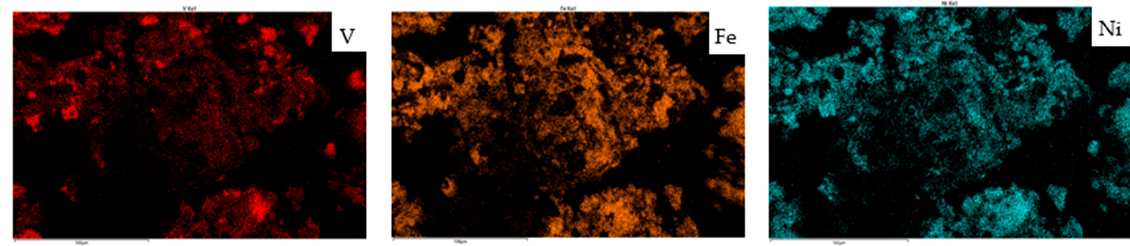
Figure 5. SEM-EDS spectra of petcoke ashed at 750 ◦ C, showing Ca and S distribution.